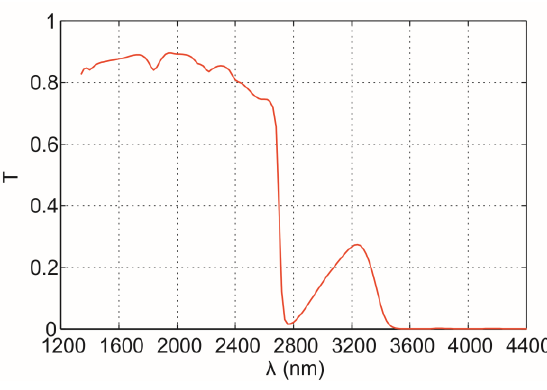
Figure 3. Total transmittance, T , of dark ceramic-glass. The spectral bandwidth of interest in the measurement procedure ranges from 1,200 to 2,600 nm.